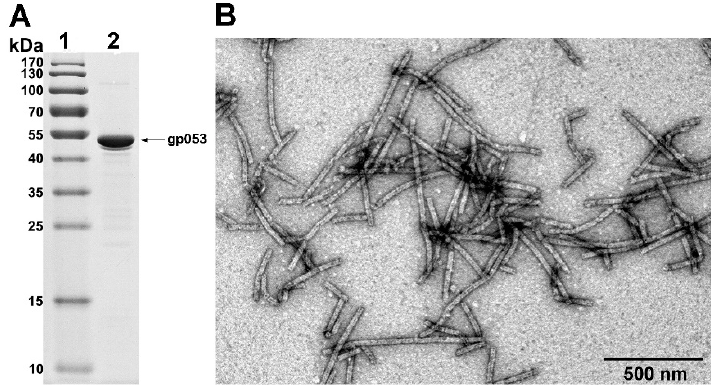
Figure 3. SDS-PAGE ( A ) and TEM ( B ) analysis of the purified wild-type recombinant gp053 produced in E. coli BL21 (DE3) cells. Protein synthesis was induced by 0.1 mM IPTG and the cells were incubated at 30 °C for 3 h. The recombinant gp053 was precipitated from the supernatant by the addition of ammonium sulphate to a final concentration of 10%. Lanes: 1—the molecular mass marker, Page Ruler TM prestained Protein Ladder Plus (Thermo Fisher Scientific, Vilnius, Lithuania); 2—the purified wild-type recombinant gp053.